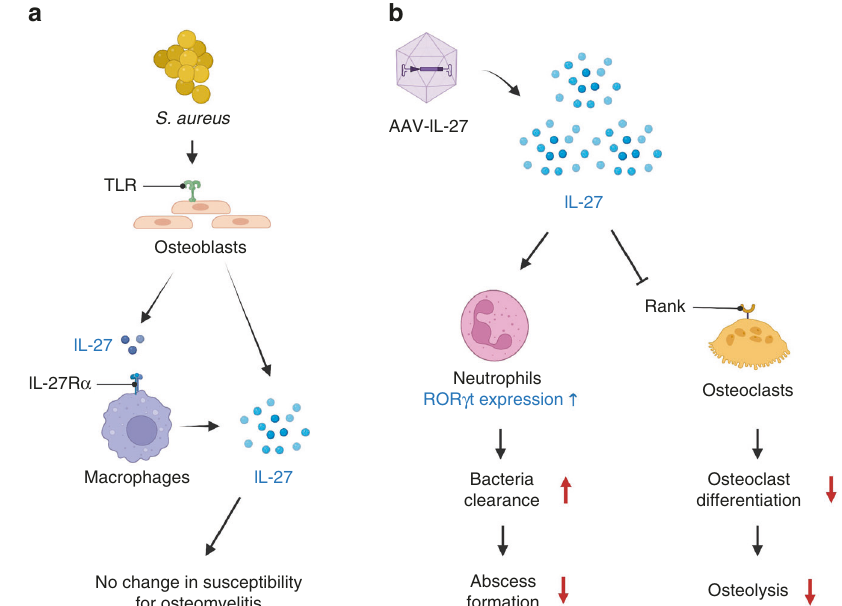
Fig. 7 Schematic model of IL-27-mediated immune regulation during S. aureus osteomyelitis. a S. aureus induces IL-27 expression via TLR activation in osteoblasts and macrophages early during the onset of osteomyelitis. Secretion of IL-27 is dependent on the autoregulatory IL-27 signaling pathway. However, endogenous IL-27 does not in fl uence host susceptibility to osteomyelitis. b On the other hand, expression of IL- 27 due to administration of rAAV-IL-27p28 at supraphysiologic levels induces the accumulation of proin fl ammatory IL-17-producing ROR γ t + neutrophils, leading to decreased abscess formation and increased bacterial clearance at the site of infection. Furthermore, the abundance of IL-27 suppresses RANK expression and inhibits osteoclast differentiation, leading to decreased bone osteolysis during chronic